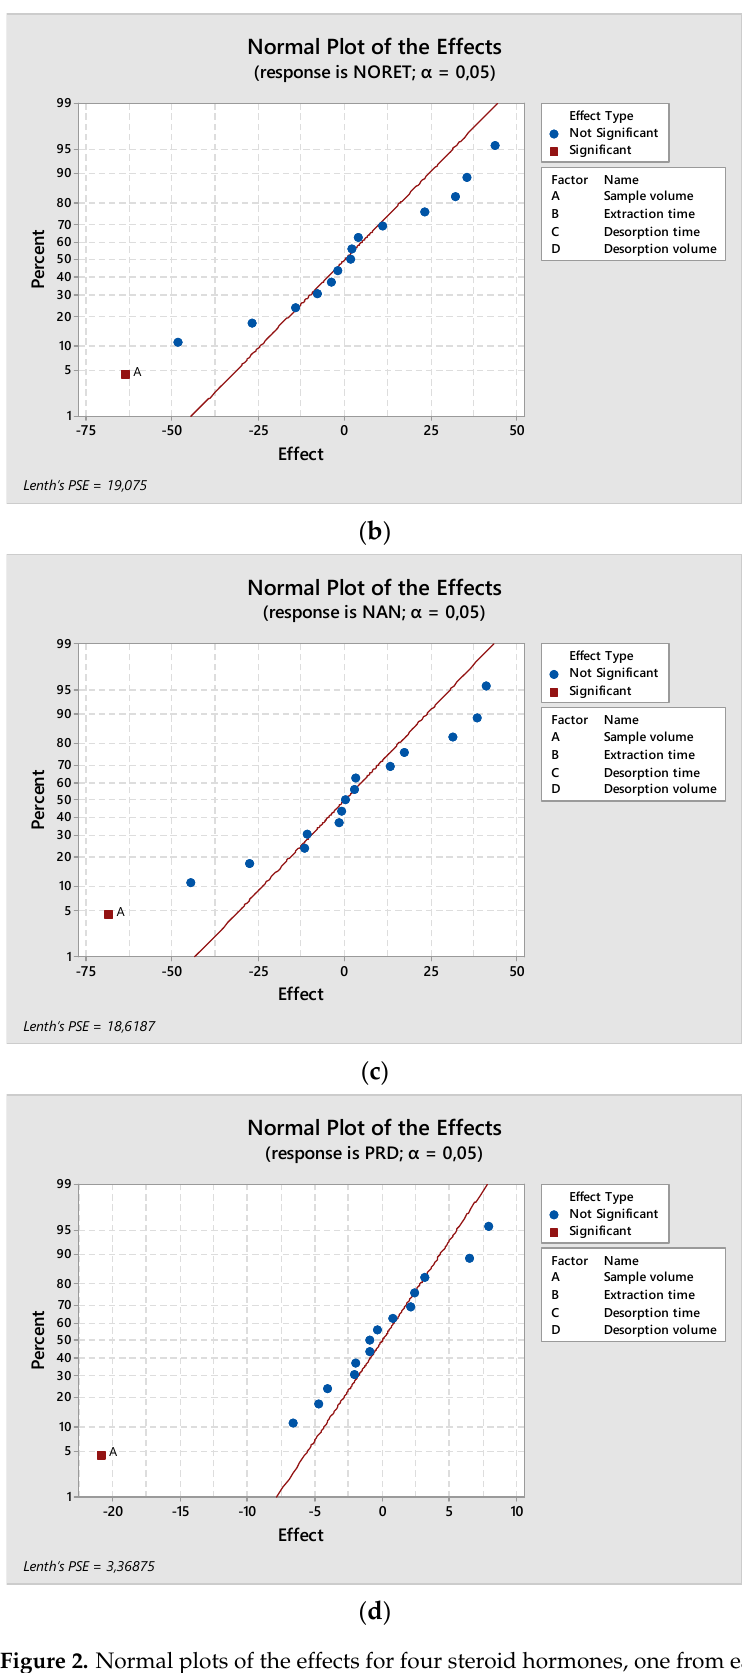
Figure 2. Normal plots of the effects for four steroid hormones, one from each family, under study: ( a ) estrogens, ( b ) progestogens, ( c ) androgens, and ( d ) glucocorticoids.